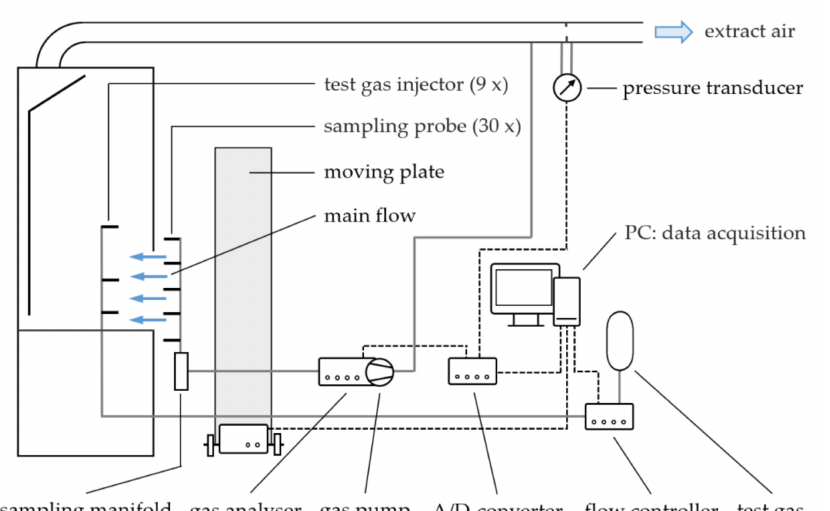
Figure 18. Experimental setup for the test of the robustness of containment according to EN 14175- 3 [38], schematic representation.